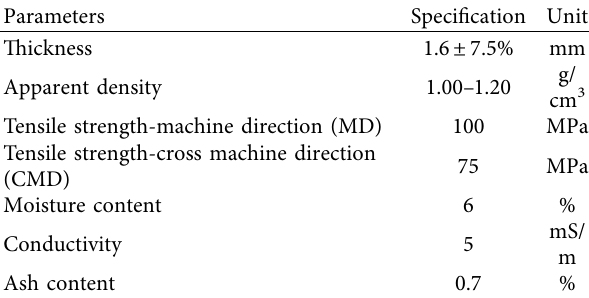
3 O 4 nanomaterial type